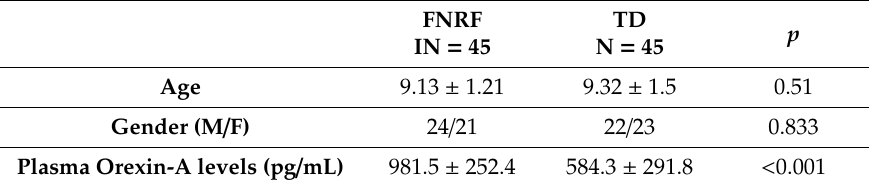
Table 1. Characteristics of participants (mean ±